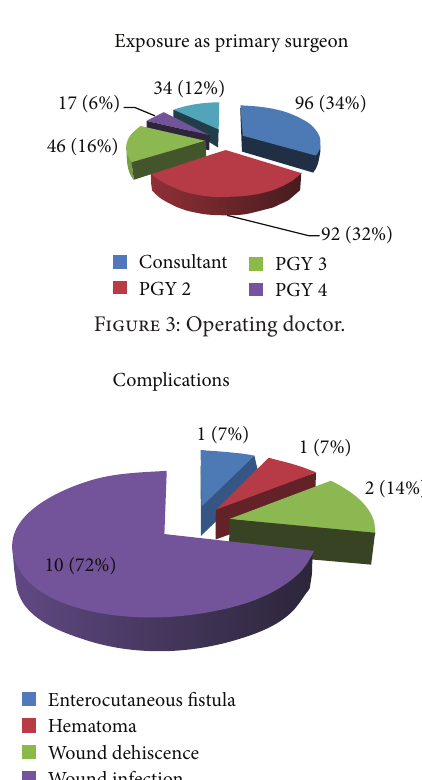
Figure 2: Diagnosis by broad categories.